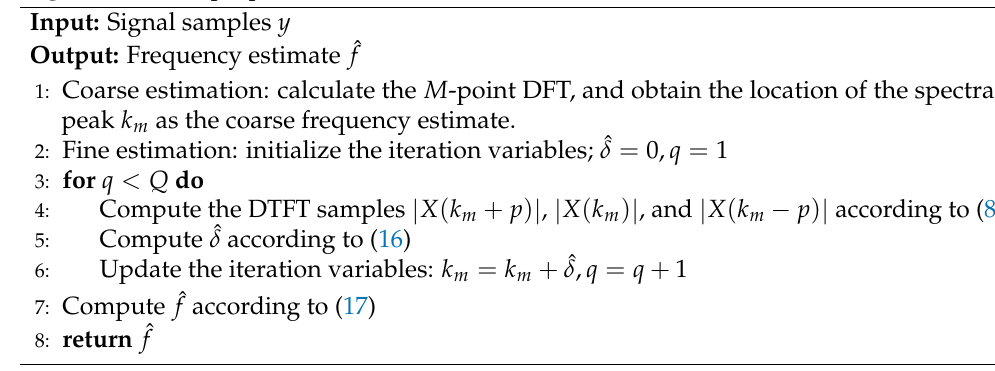
Algorithm 1 The proposed iterative